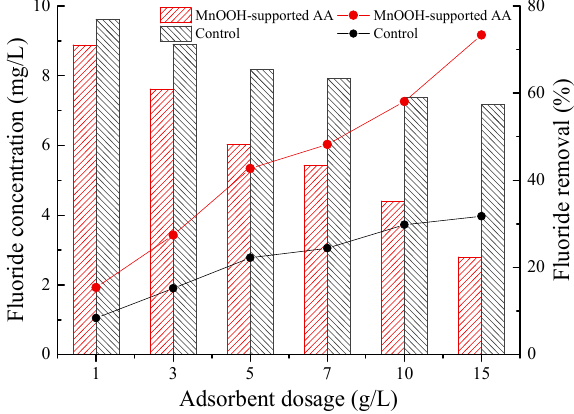
Figure 7. Effect of the MnOOH-supported AA and AA on defluoridation.